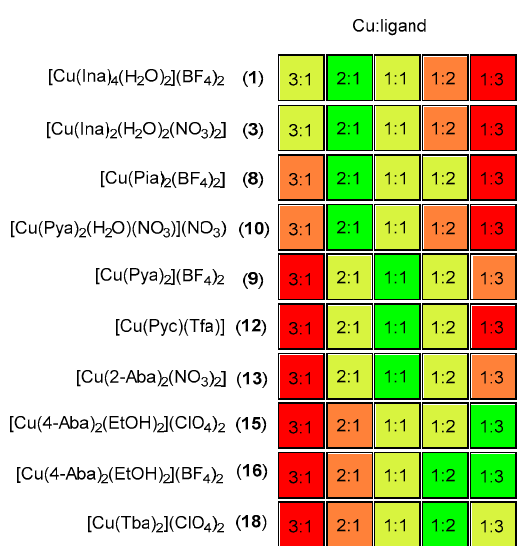
Scheme 2. Results of reproduction and optimisation reactions with yields and purities decreasing along the colour series: . Yields were defined relative to the ligands (for details, see Experimental Section).